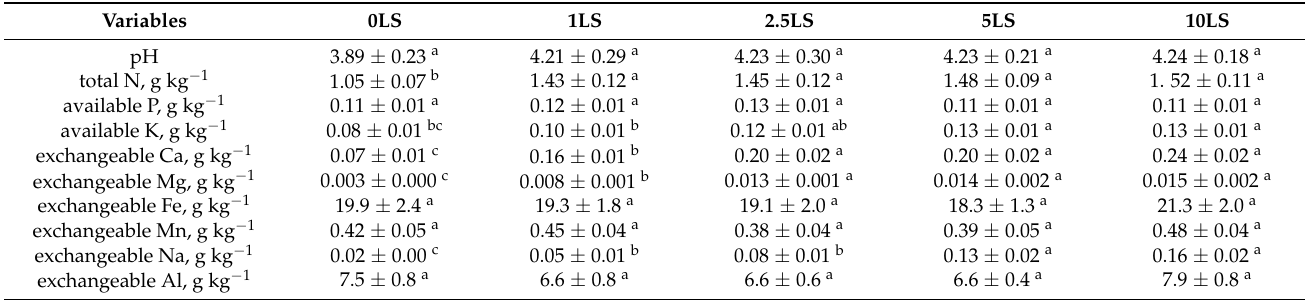
Table 2. The pH values and nutrient content in the soil substrates containing 0 (0LS), 1 (1LS), 2.5 (2.5LS), 5 (5LS), and 10 (10LS) %